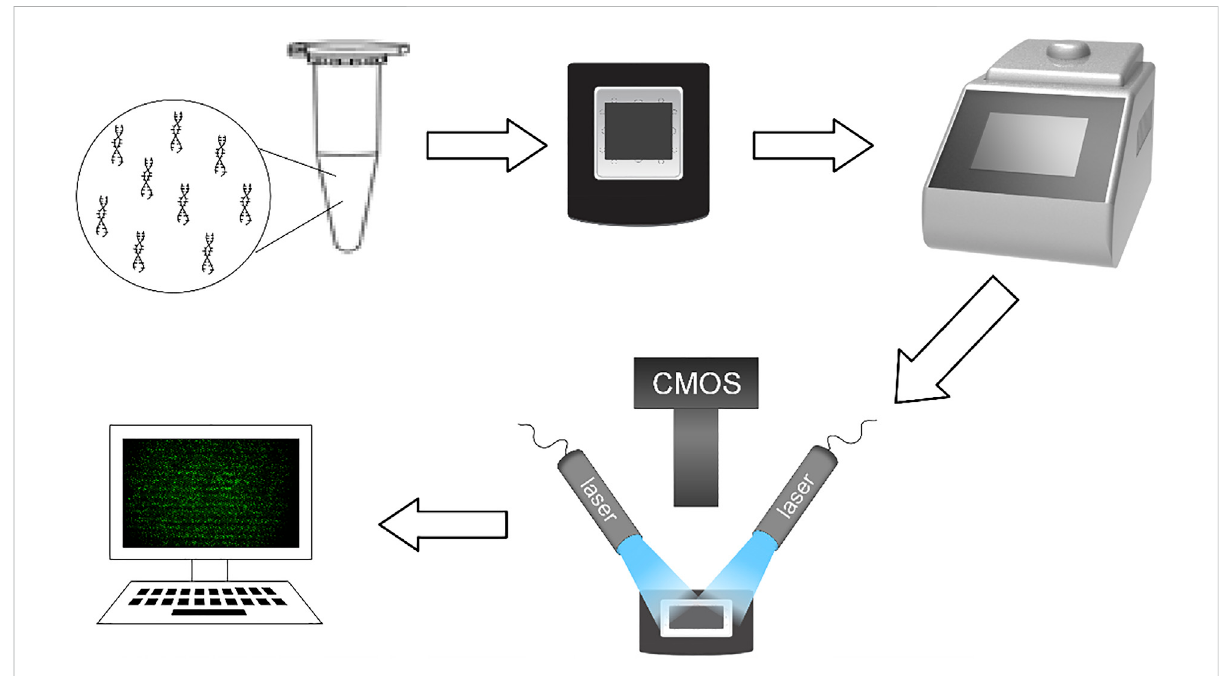
FIGURE 1 Flow chart of dPCR